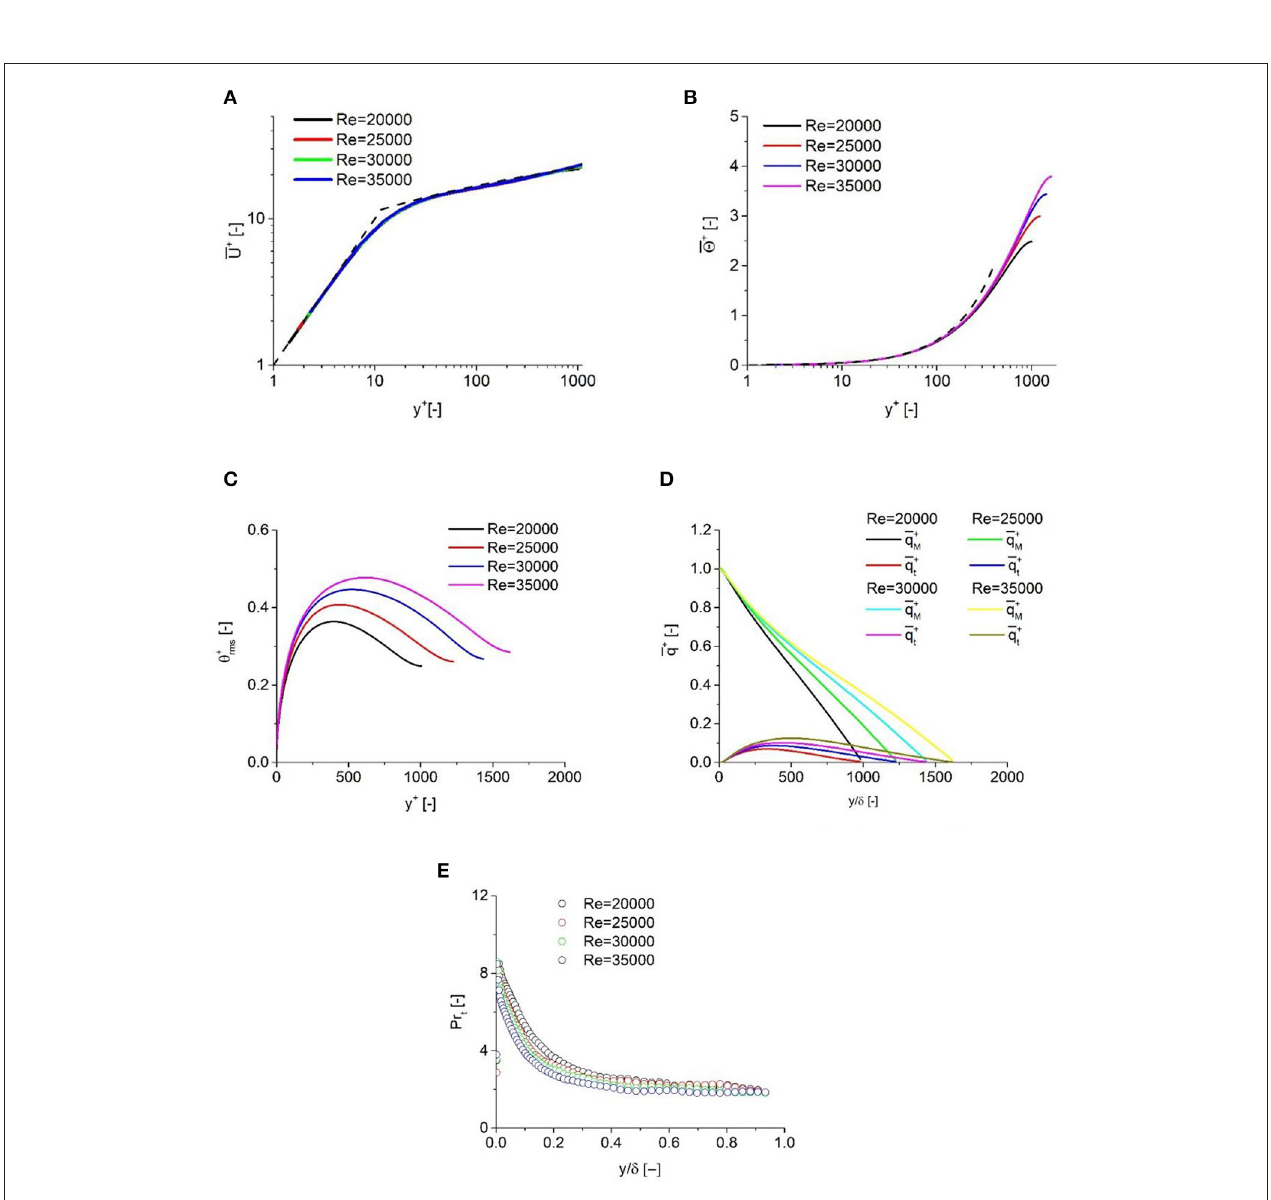
FIGURE 5 | Dependency on Reynolds number. (A) Mean velocity, (B) Mean temperature, (C) Temperature fluctuation, (D) Heat flux decomposition, and (E) Turbulent Prandtl number.